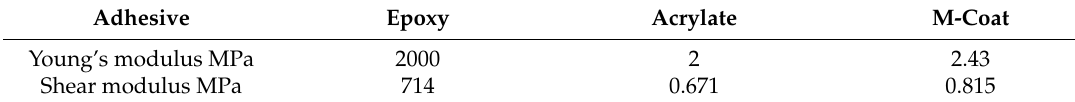
Table 2. Material properties of three different adhesives.